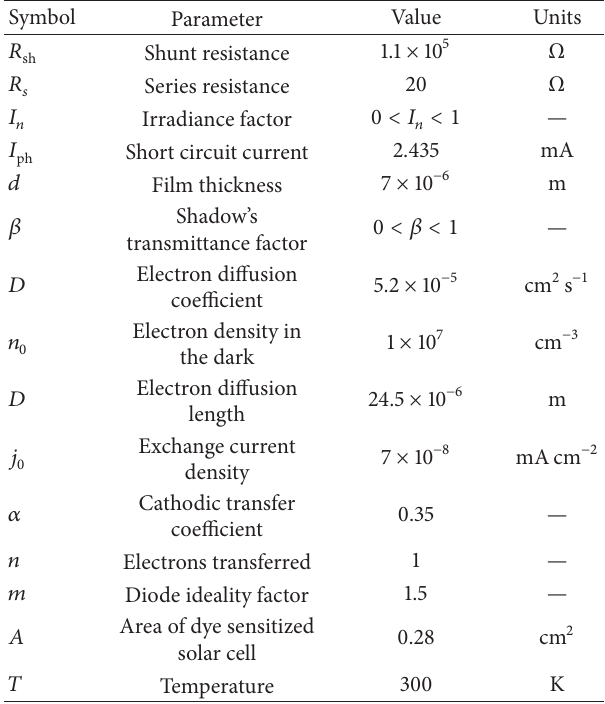
Table 4: Best fitting parameters and experimental values to fit experimental data to